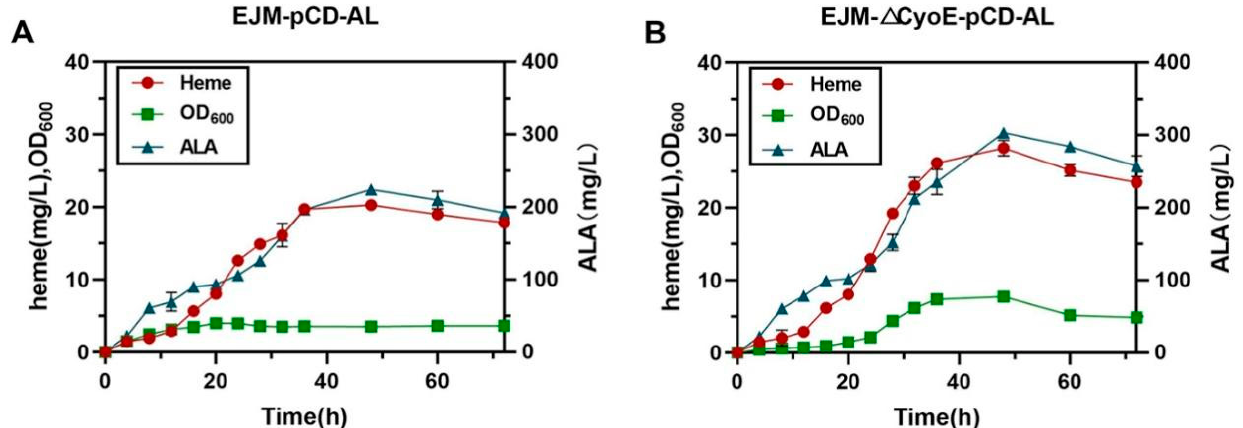
Figure 6. Fed-batch fermentation results of engineered strains. ( A ) Fed-batch fermentation profiles of the strain EJM-pCD-AL during 72 h. ( B ) Fed-batch fermentation profiles of the strain EJM- △ CyoE-pCD-AL during 72 h. The red circle represents heme production, the green square represents OD 600 and the blue triangle represents ALA production.